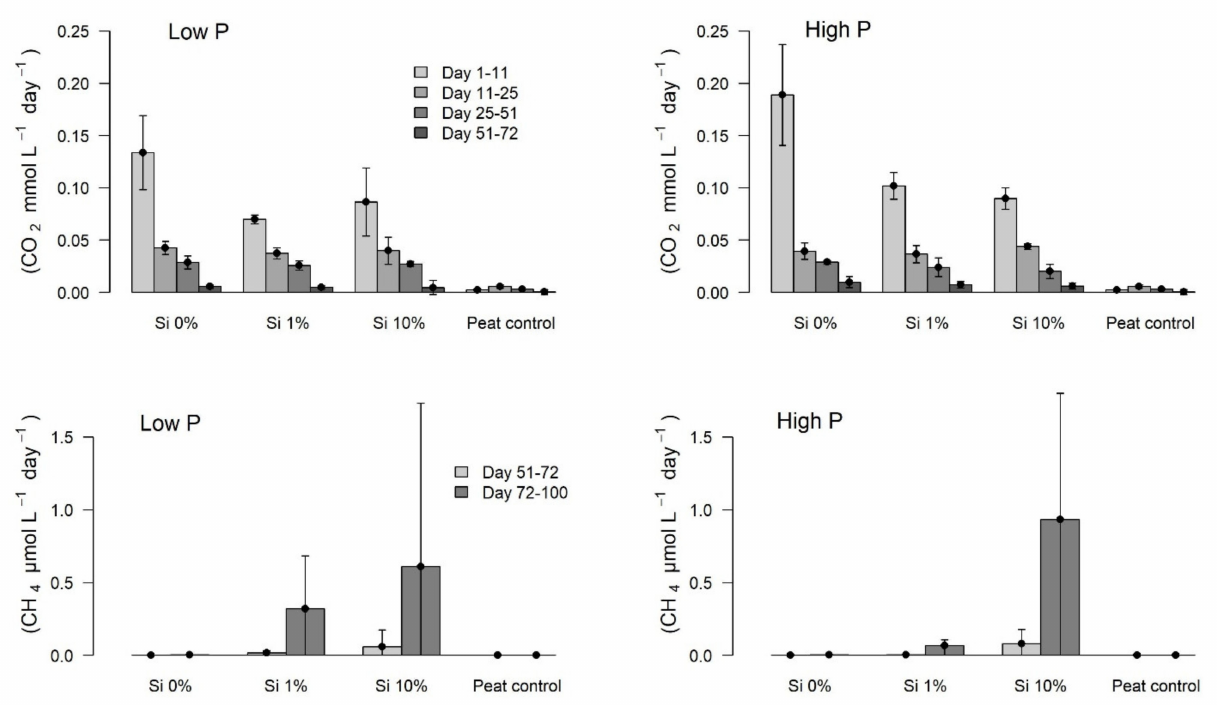
Figure 3. CO 2 (top) and CH 4 (bottom) production rates during the initial phase (day 1–11) and the long-term incubation period of Eriophorum shoots. Methanogenesis only started after 50 days, therefore the time before is not displayed in the graphs at the